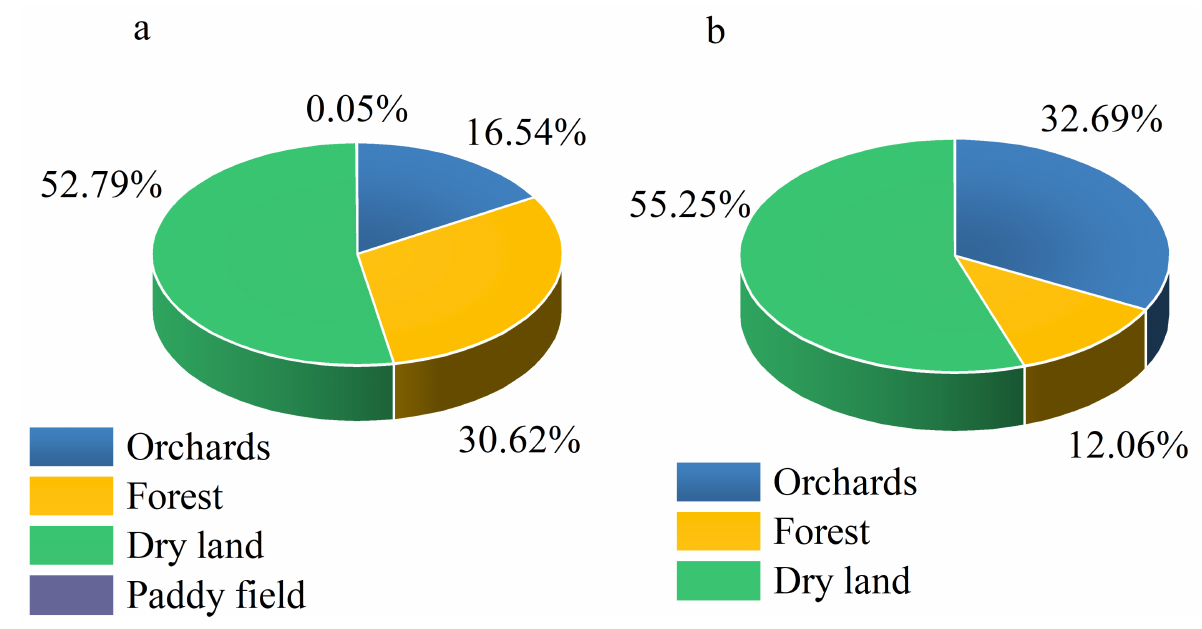
Figure 3. Relative sediment contribution proportions of ( a ) source group 1 and ( b )source group 2. Table 7. Results of KW-H test for performance of each property of source group 2.